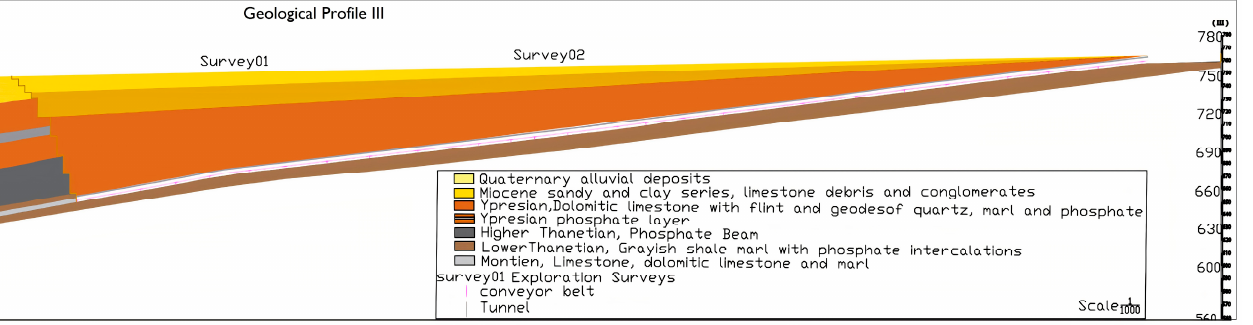
Figure 5. Final profile—III—of environmental recovery showing the layers and the tunnel built over the conveyor belt.